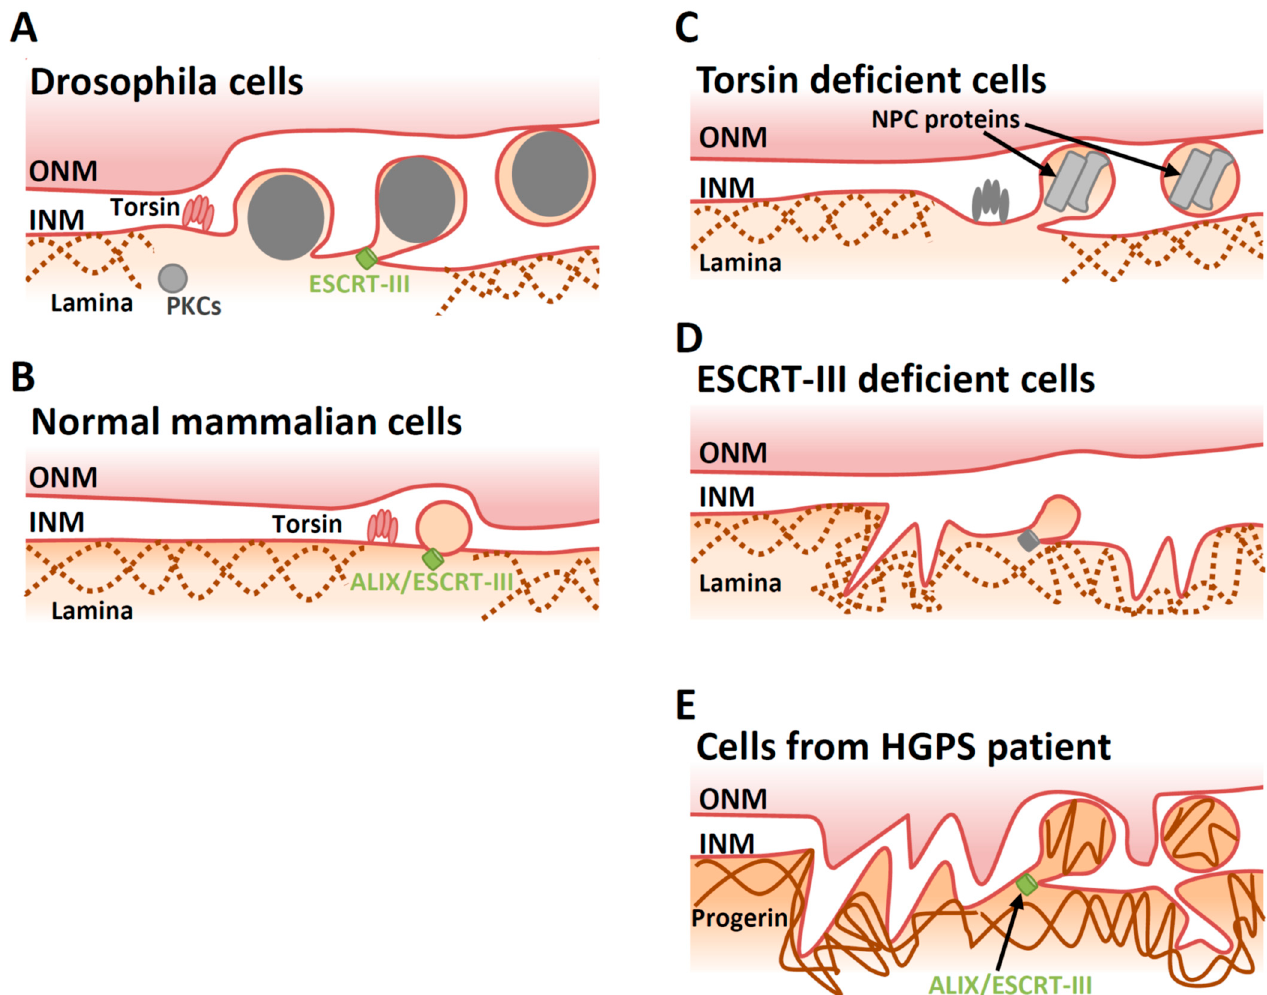
Figure 4. Proposed models of vesicle-mediated cytoplasmic transport in various situations. ( A ) A large RNP complex exits from the nucleus through vesicle-mediated nucleocytoplasmic transport system in Drosophila cells. ( B ) In ‘normal’ mammalian cells, torsins and ESCRT-III might contribute to eliminate excess INM and/or INM proteins. This process might be similar to the vesicle-mediated nucleocytoplasmic transport of HSV-1 nucleocapsids. ( C ) In torsin-deficient cells, herniations and vesicles containing NPC proteins within the perinuclear space are produced. ( D ) In ESCRT-III-deficient cells, INM proliferation is induced. ( E ) In cells from HGPS patients, progerin (mutant lamin A) accumulates in the nucleus, resulting in nuclear envelope deformation and defects including vesicles in the perinuclear space. ESCRT-III represses membrane deformation in these cells.